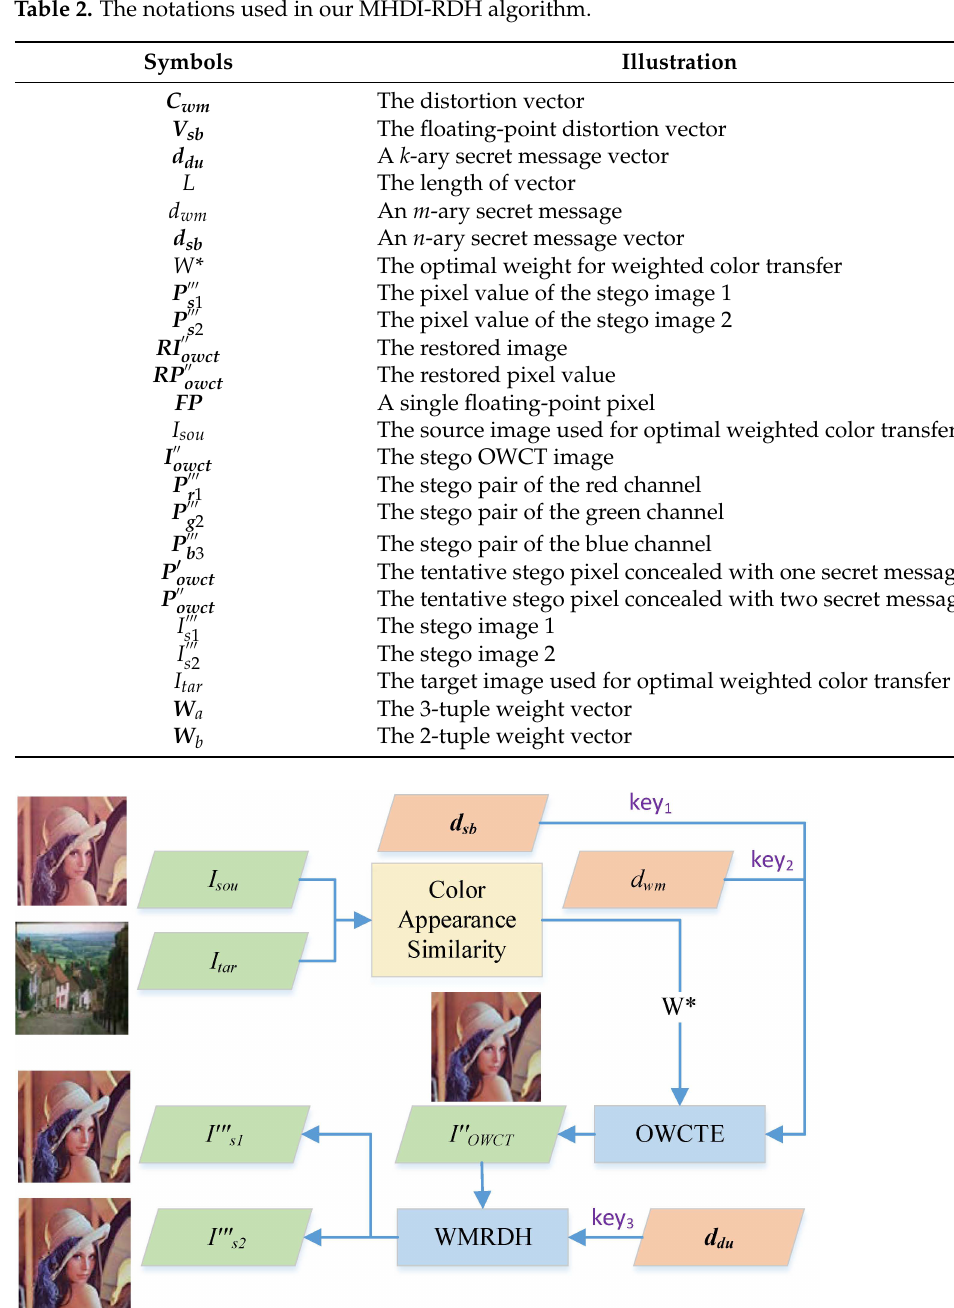
Table 2. The notations used in our MHDI-RDH algorithm.